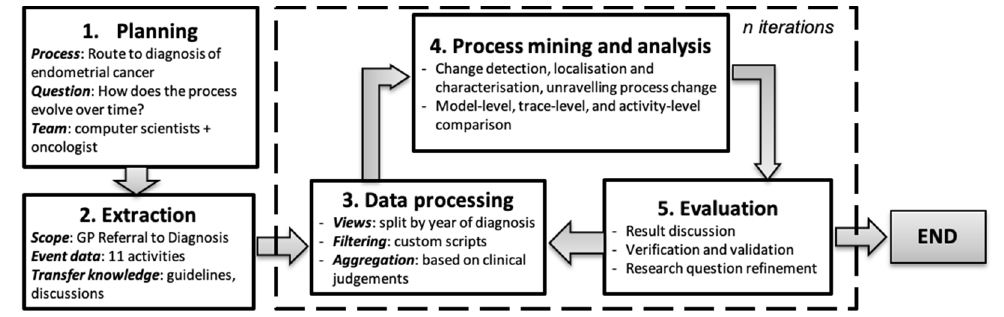
Figure 1. The general methodology.